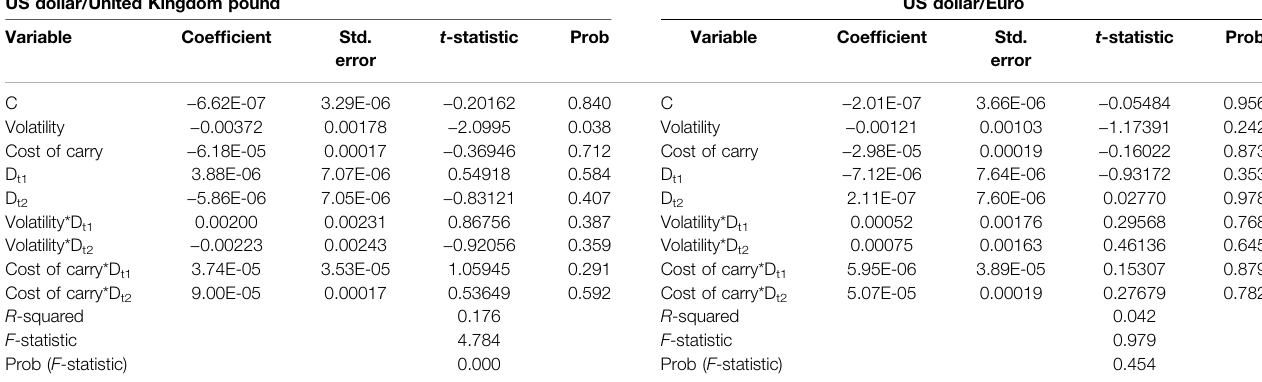
TABLE 7 | Dummy variable test results for US dollar/UK pound and US dollar/Euro. US dollar/United Kingdom